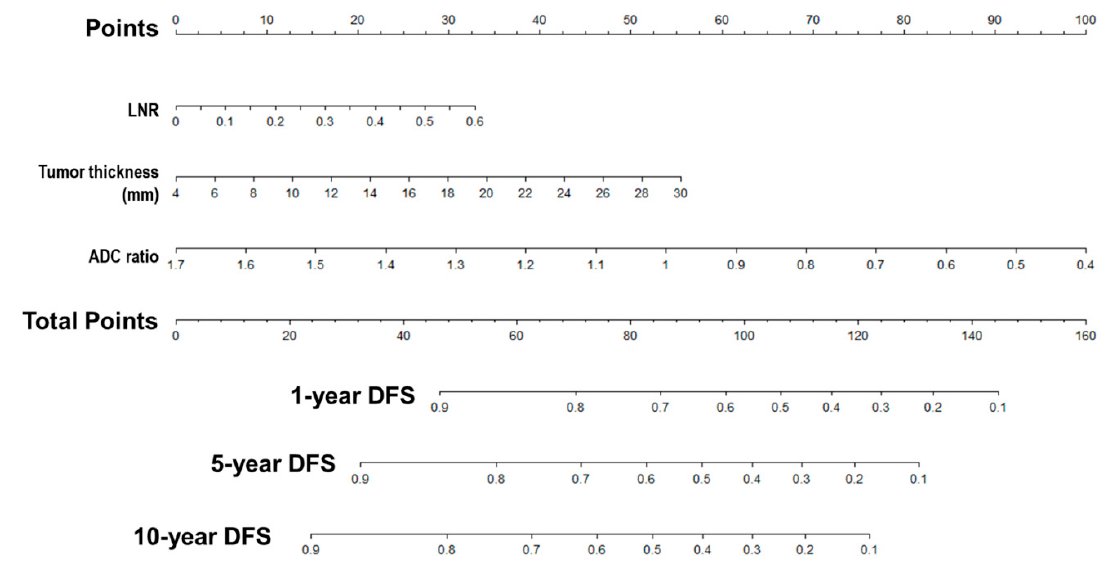
Figure 6. Nomogram predicts DFS reliably and predictive accuracy is internally validated. A nomogram for Disease-Free Survival Prediction. LNR, lymph node ratio; ADC, apparent diffusion coefficient; DFS, disease-free survival.